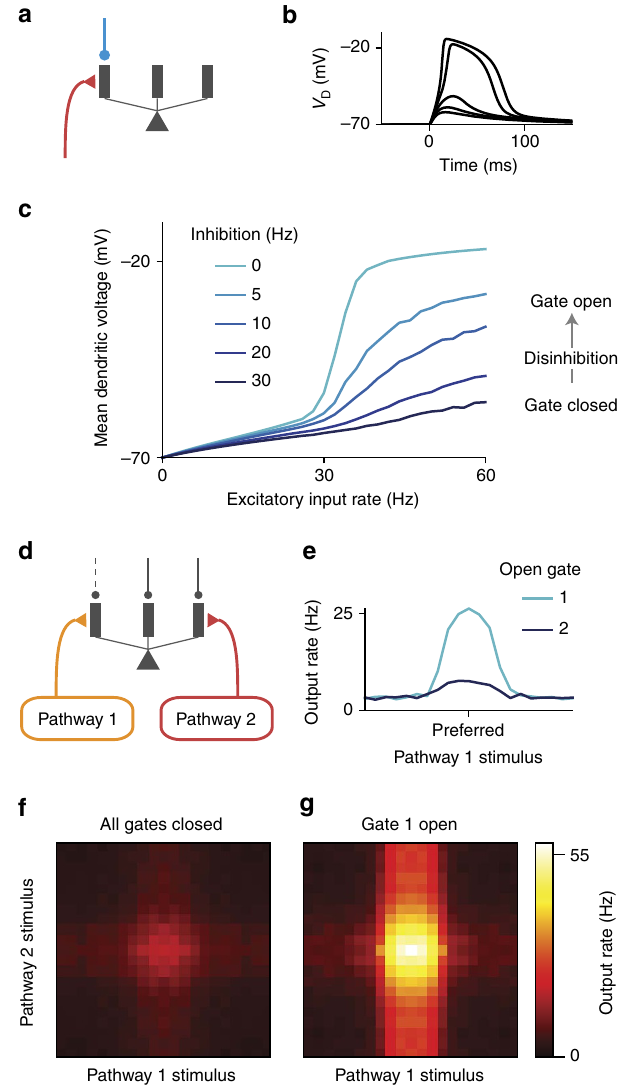
stimulus, although pathway 2 has a residual